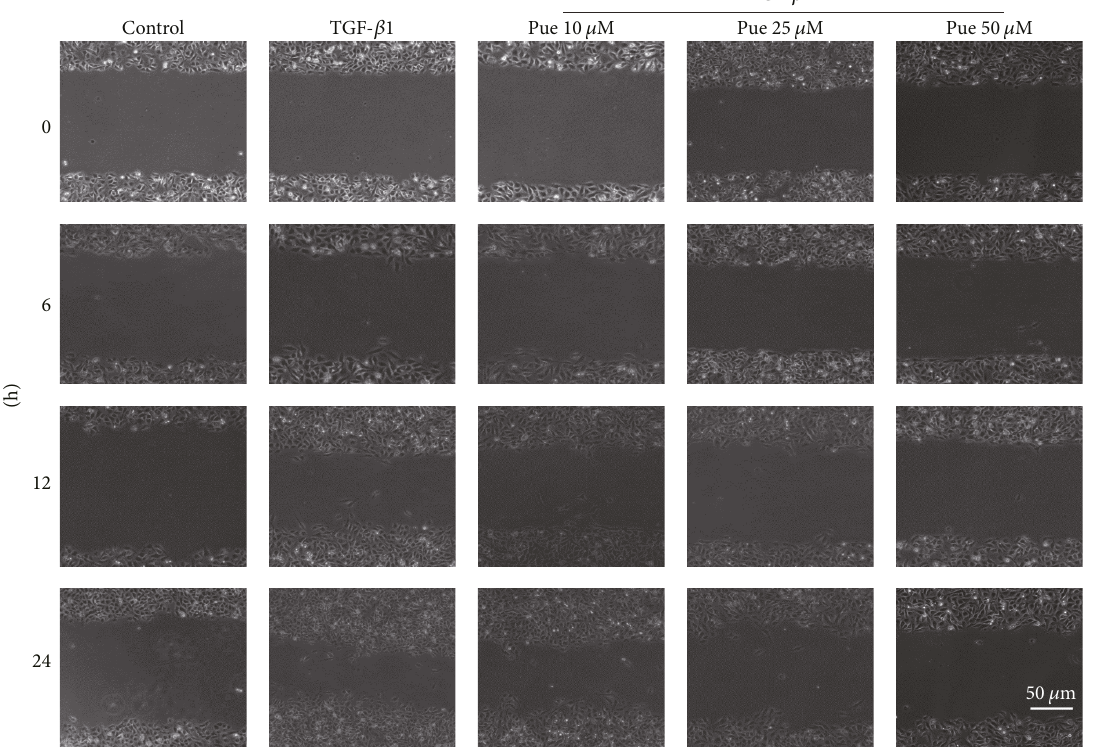
Figure 4: Puerarin inhibited TGF- 𝛽 1-induced HUVECs migration rate . HUVECs were preincubated with different concentrations of puerarin (10, 25, and 50 𝜇 M) for 30 min and then treated with TGF- 𝛽 1 (10ng/ml) for 48 h until a monolayer was formed. Scratches were made straightly across the dishes. After rinsing twice, the medium was replaced by RPMI1640 with no FBS. Photographs were taken at indicated times (scale bars: 50 𝜇